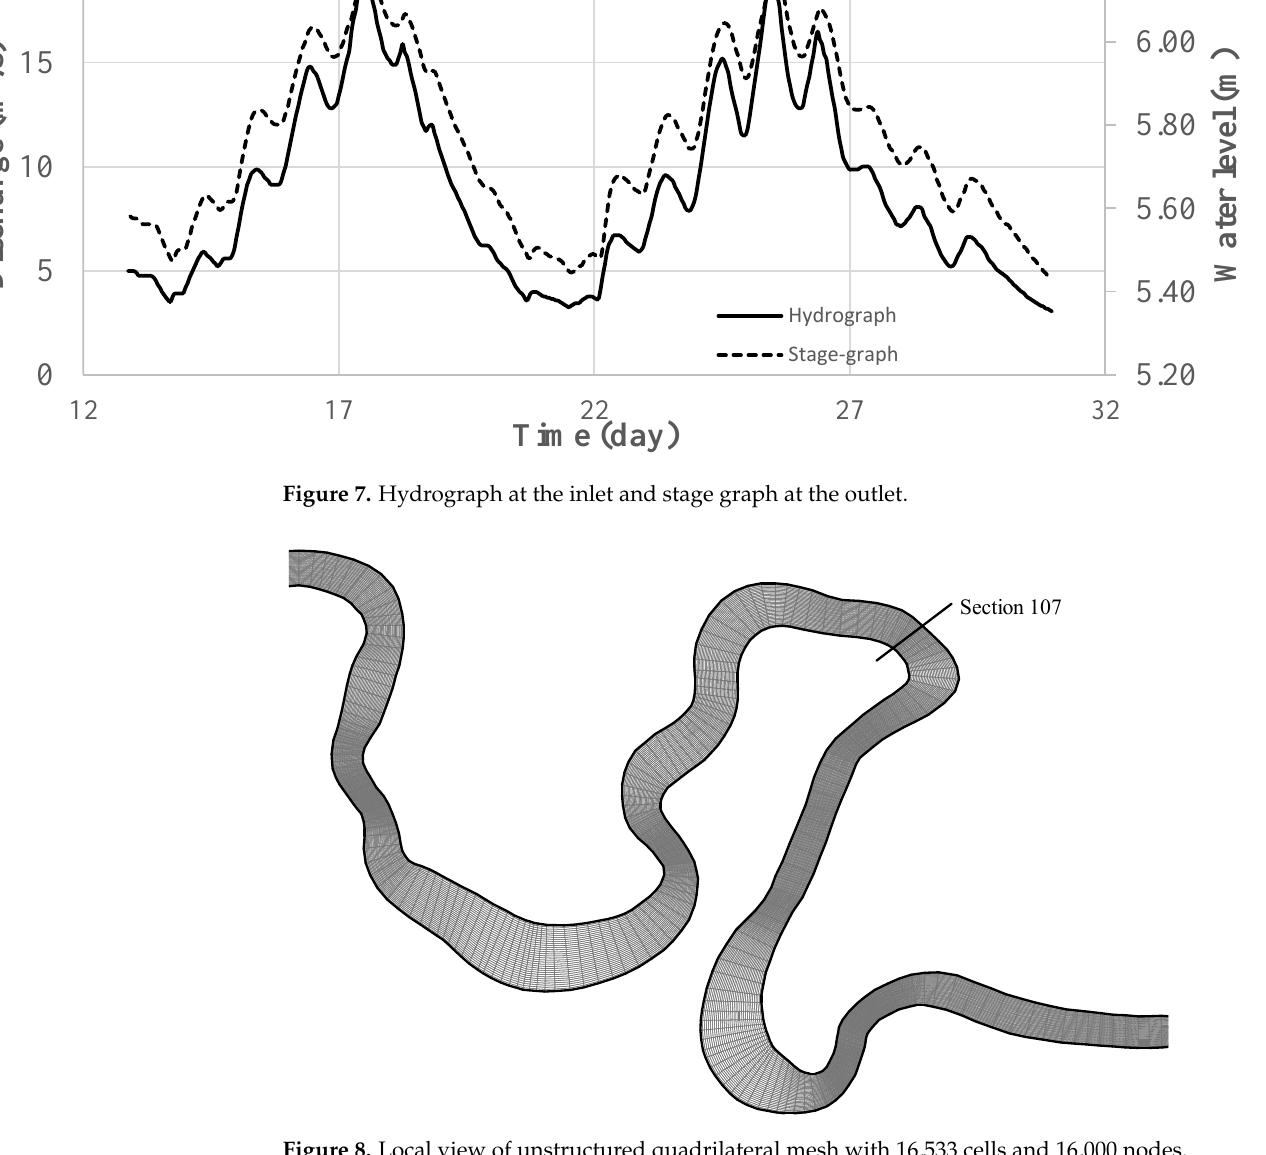
Figure 8. Local view of unstructured quadrilateral mesh with 16,533 cells and 16,000 nodes. The measured water surface elevation at section 107 was used to calibrate the Manning coefficient, and Figure 9 compares the simulated and measured water surface profiles at section 107 using the calibrated Manning coefficient of 0.03 m − 1/3 s for the whole reach and the time step of 3 s. As can be seen, the simulated profile matched well with the measured one.